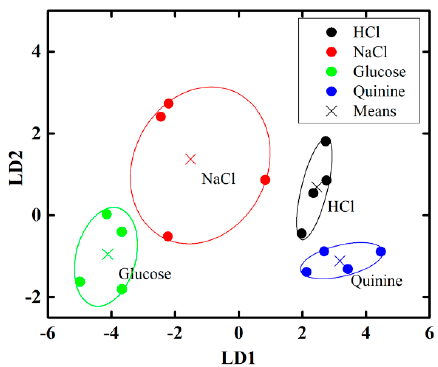
Figure 15. LDA results for the dataset obtained by sensing mixed taste (HCl, NaCl, glucose, and quinine-HCl) solutions with the proposed IDC electronic tongue.